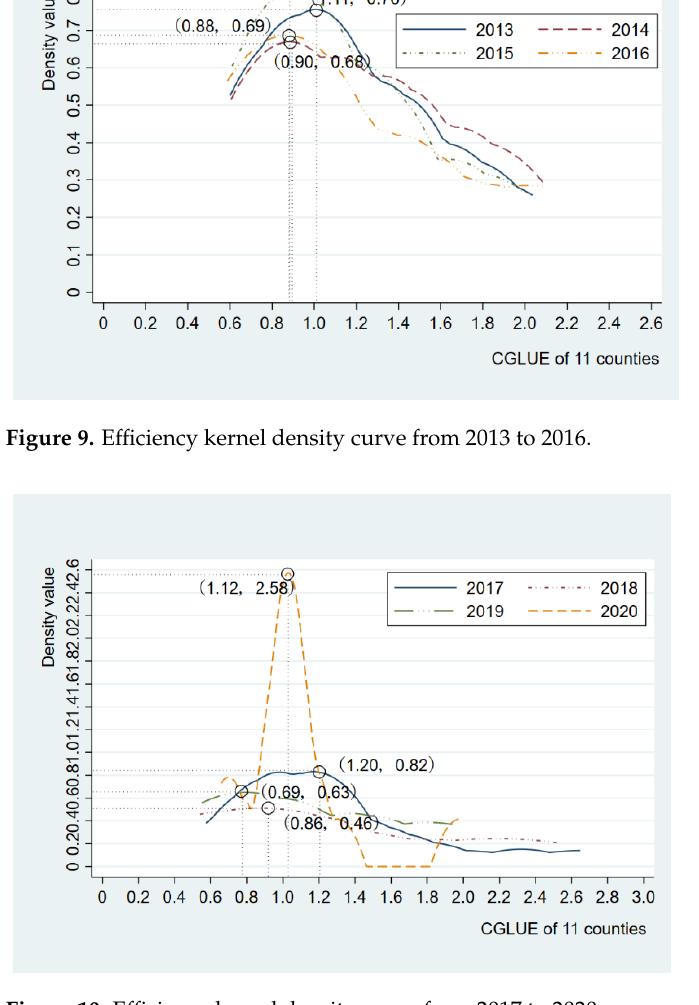
Figure 10. Efficiency kernel density curve from 2017 to